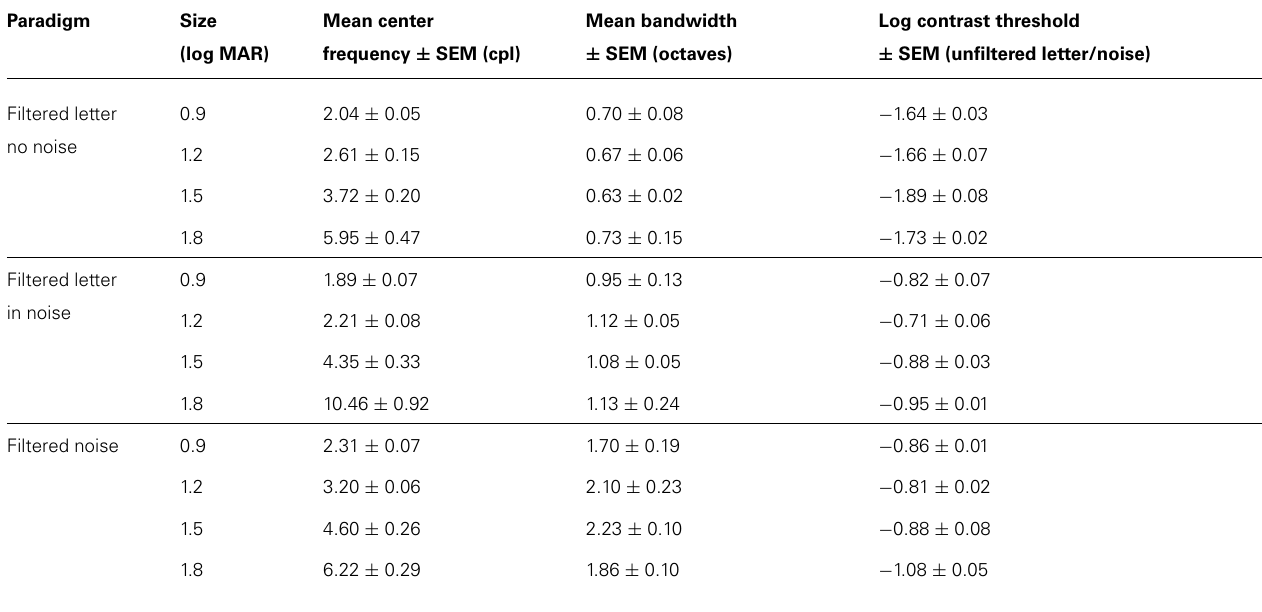
Table 1 | Center frequency, bandwidth, and contrast threshold for each letter size and paradigm.